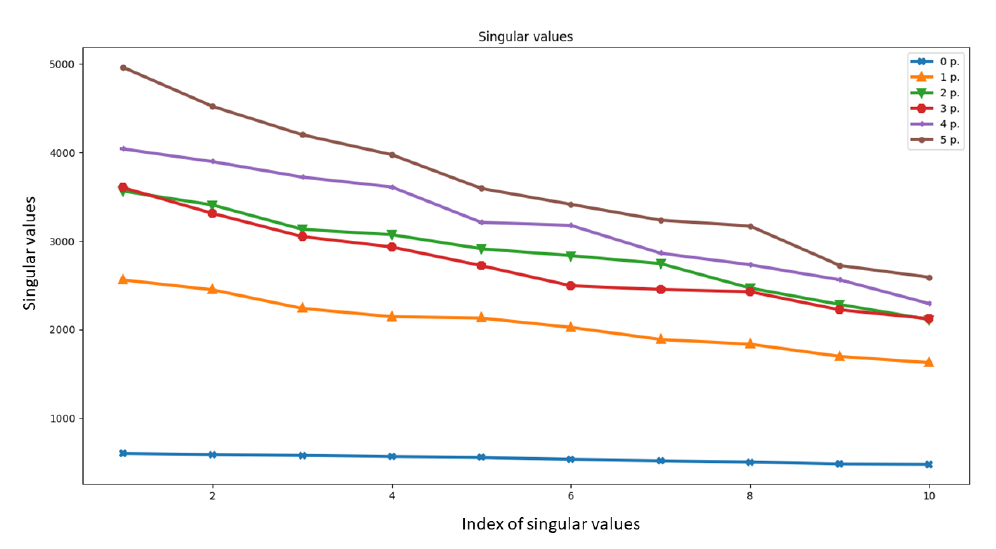
Figure 1. Singular values for different number of people in room